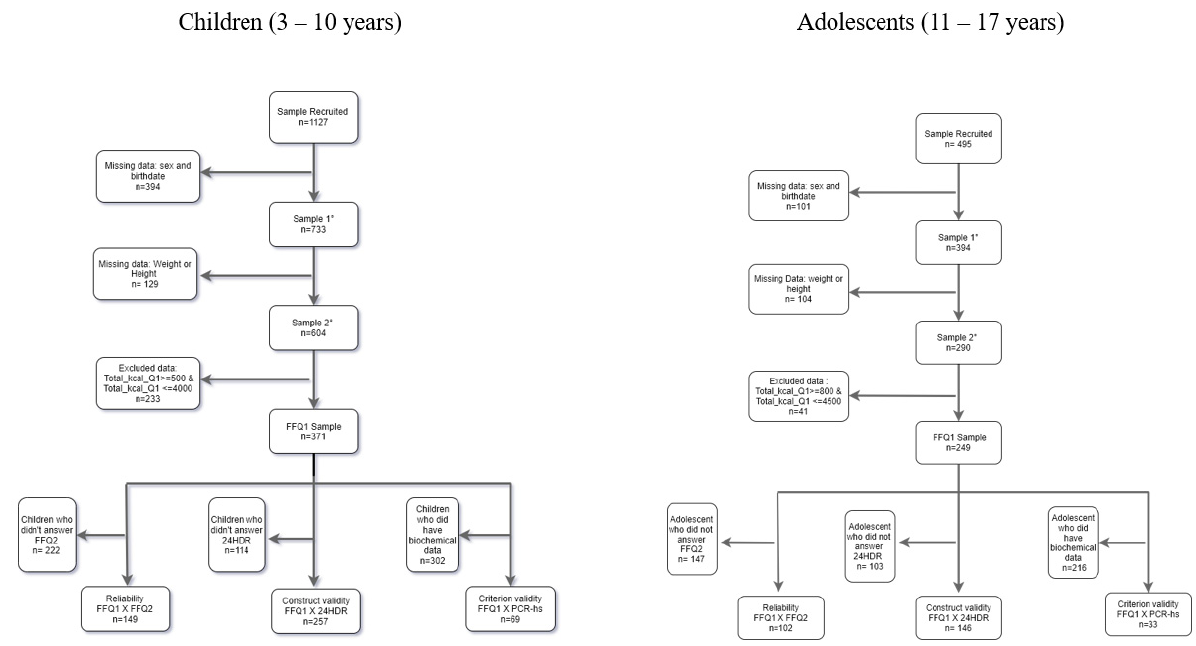
Figure 1. Flowchart that indicates the sampling process according to the type of analysis to be per- formed.